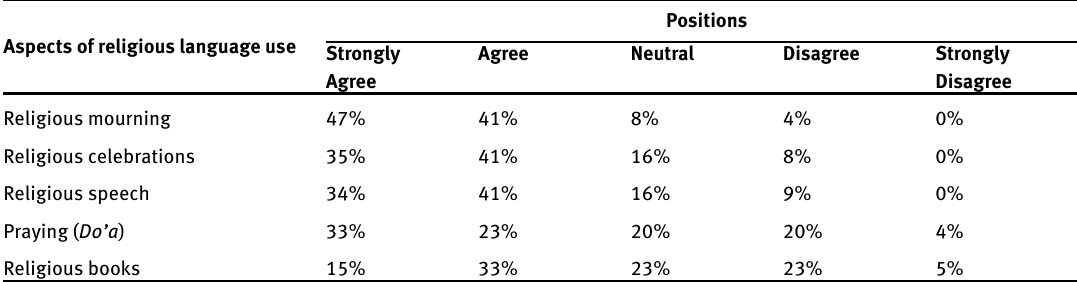
Table 3. Positions towards language use in the domain of